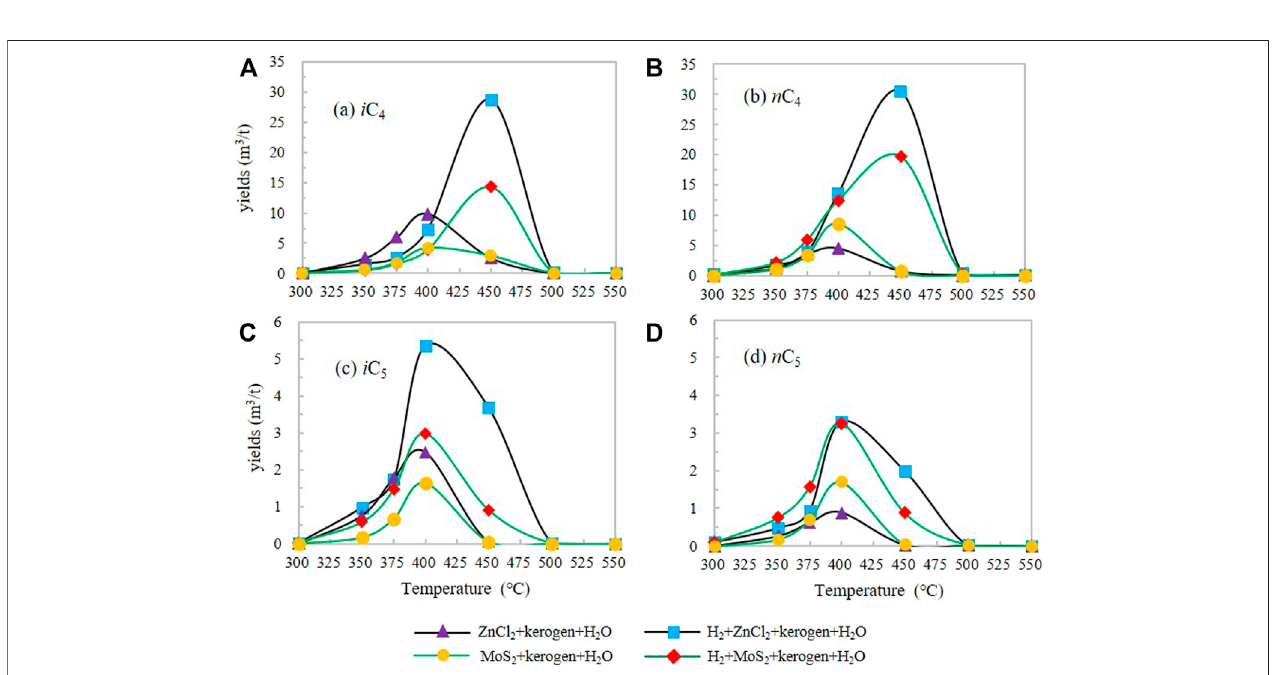
FIGURE 2 | The yield characteristics of i C 4 (A) , n C 4 (B) , i C 5 (C) , n C 5 (D) under different catalytic hydrogenation control conditions of the closed system.